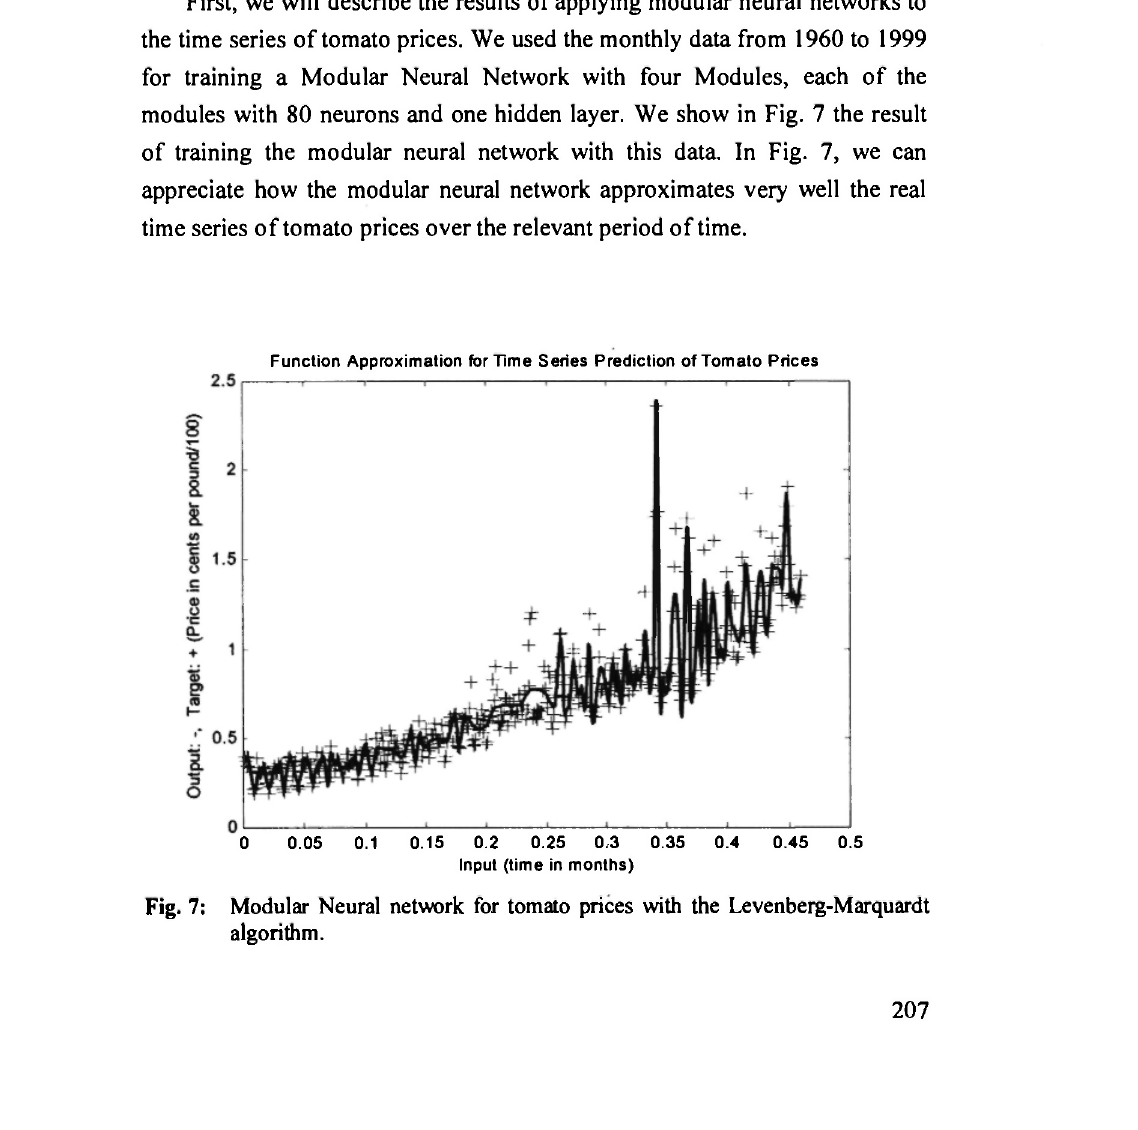
Fig. 7: Modular Neural network for tomato prices with the Levenberg-Marquardt